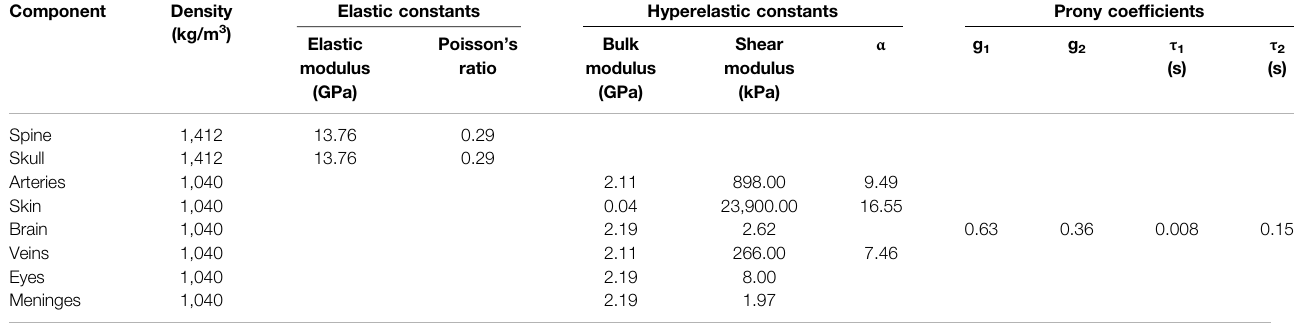
TABLE 1 | Summary of the material properties used for the individual anatomical components included in the high- fi delity, detailed-vasculature human-head model. Component